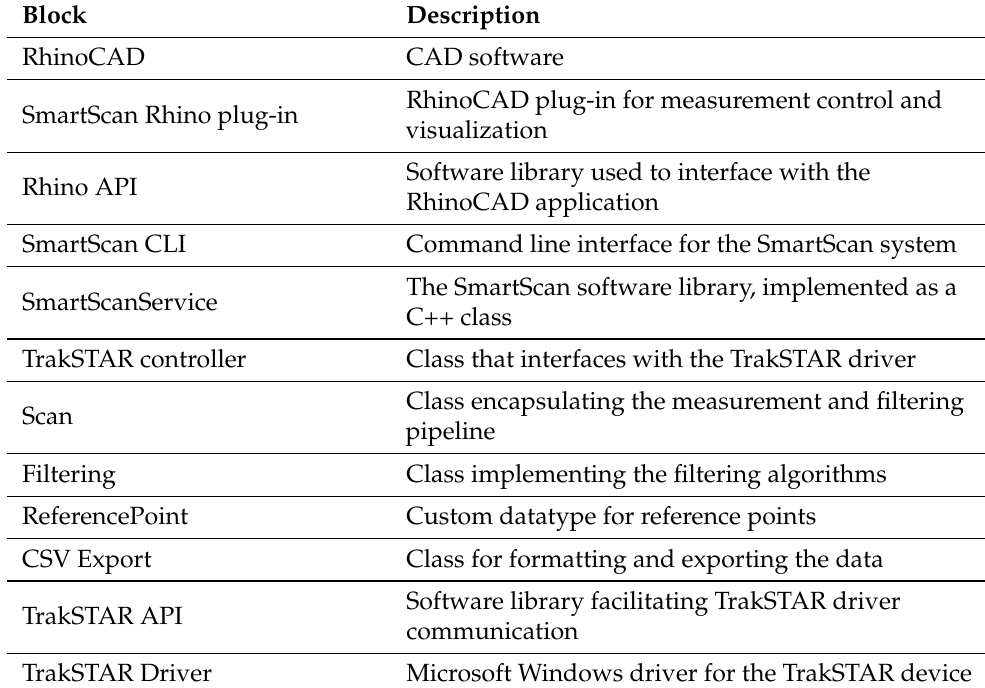
Table 1. Software blocks for sensor data collection, filtering and